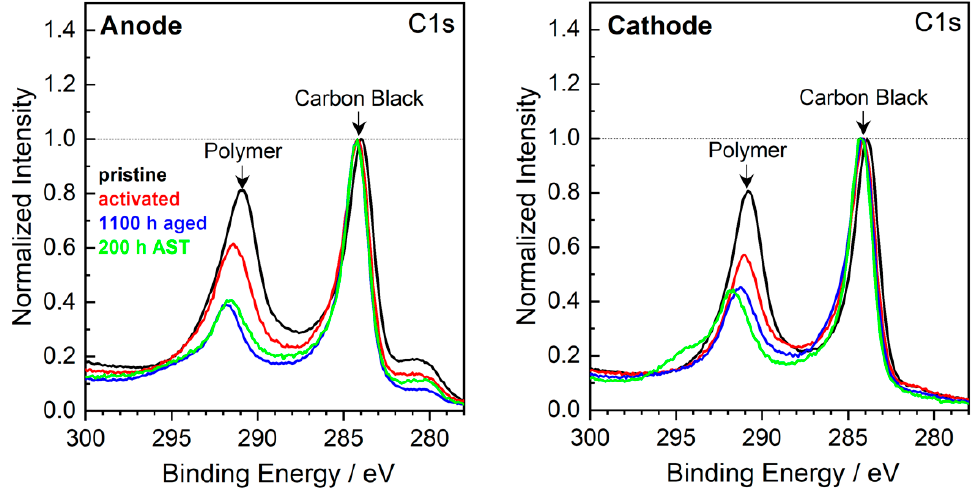
Figure 6. XPS detailed spectra of the C1s region of pristine, activated, 1100 h aged [10] and 200 h AST MEAs. The spectra are normalized with respect to the intensity of the 284 eV peak.